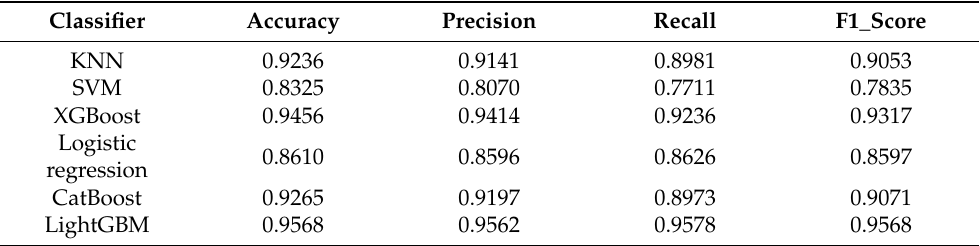
Table 6. Performance comparison of the suggested approach with other machine learning